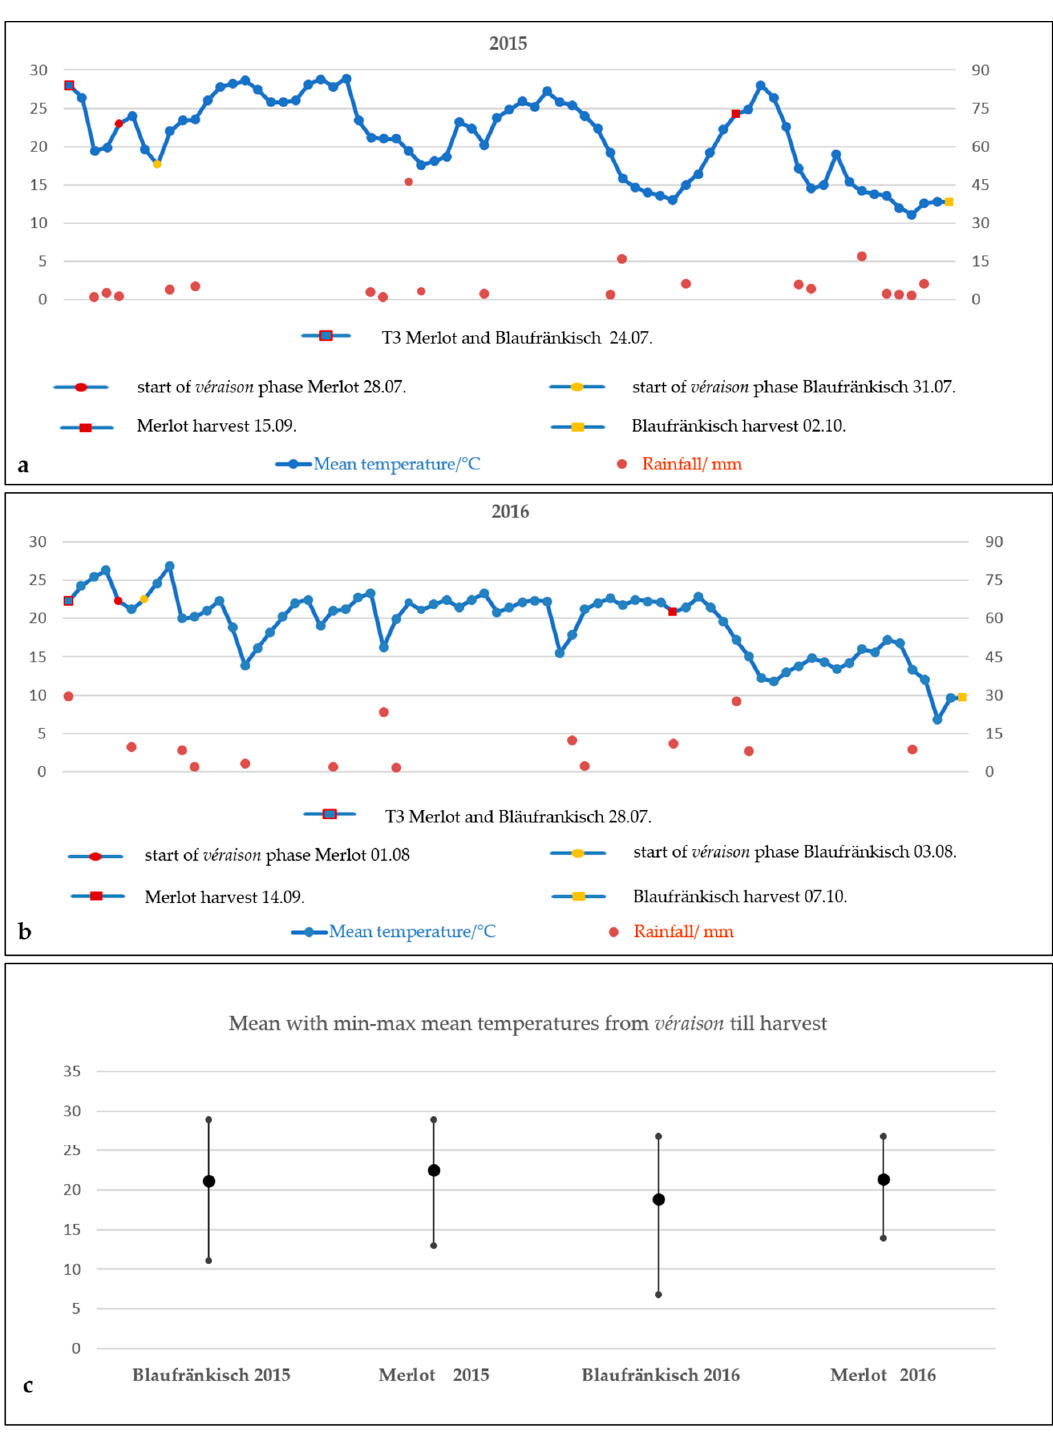
Figure 1. ( a ) Mean temperature (°C, left axis) and rainfall (mm, right axis) trend from T3 treatment till harvest date in 2015; ( b ) Mean temperature and rainfall trend from T3 treatment till harvest in 2016; ( c ) Mean with min ‐ max mean temperatures from véraison till harvest date.